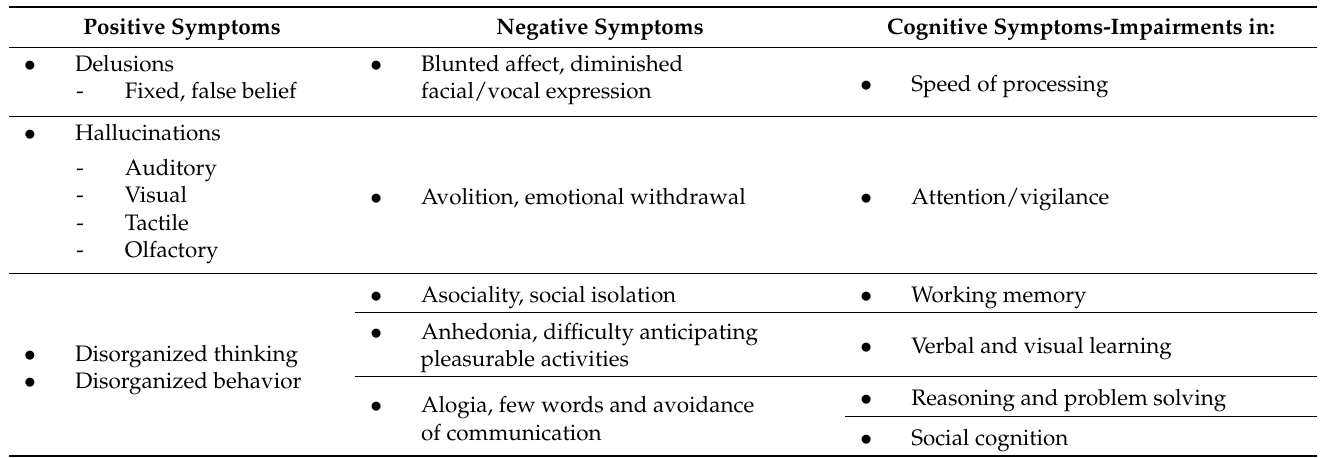
Table 1. Schizophrenia is characterized by symptoms that can be grouped into positive, negative, and cognitive do- mains